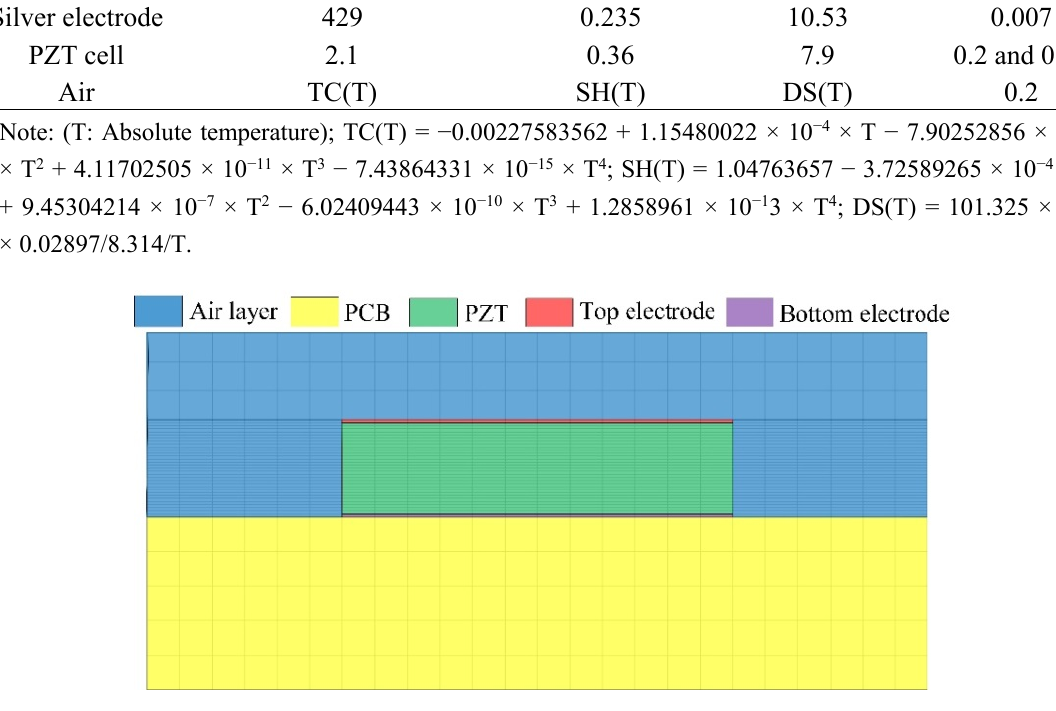
Figure 4. Regular meshed finite element model for the PZT pyroelectric